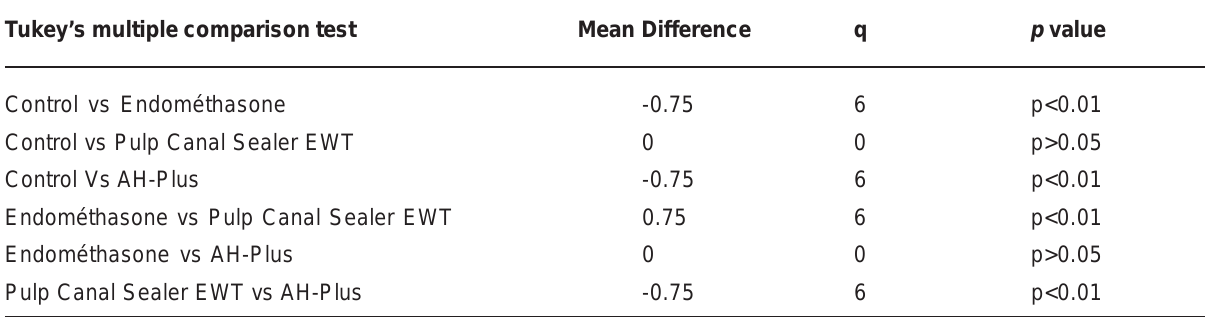
TABLE 2- Results of Tukey’s multiple comparison test for the scores attributed to the materials (Day 3)